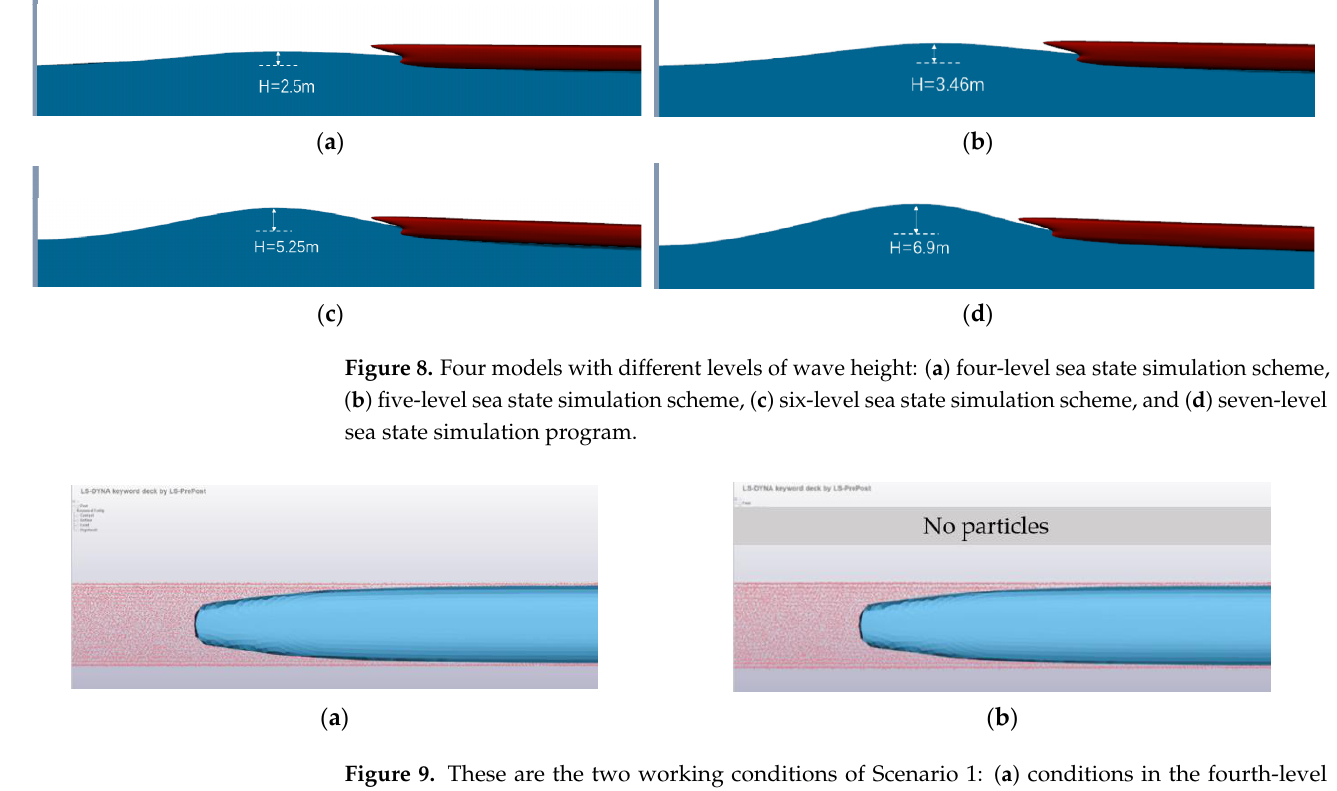
Figure 8. Four models with different levels of wave height: ( a ) four-level sea state simulation scheme, ( b ) five-level sea state simulation scheme, ( c ) six-level sea state simulation scheme, and ( d ) seven-level sea state simulation program.